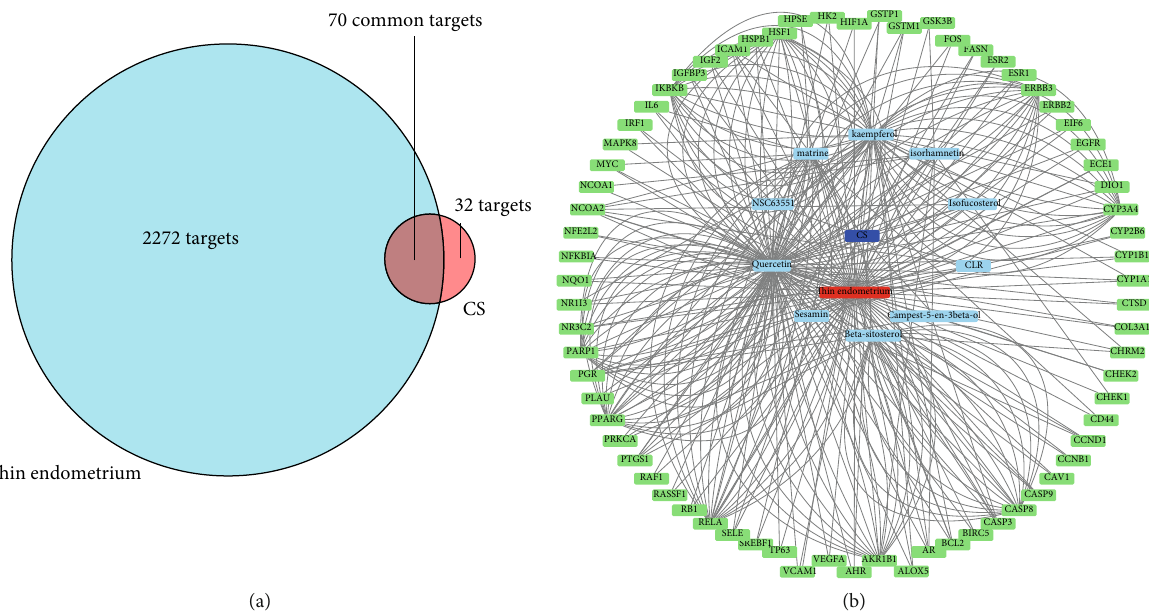
Figure 2: (a) Venn diagram of 70 druggable targets of CS which were also therapeutic targets of thin endometrium. (b) Disease-target- compound network based on the 10 bioactive compounds of CS and the 70 thin endometrium-CS common targets.